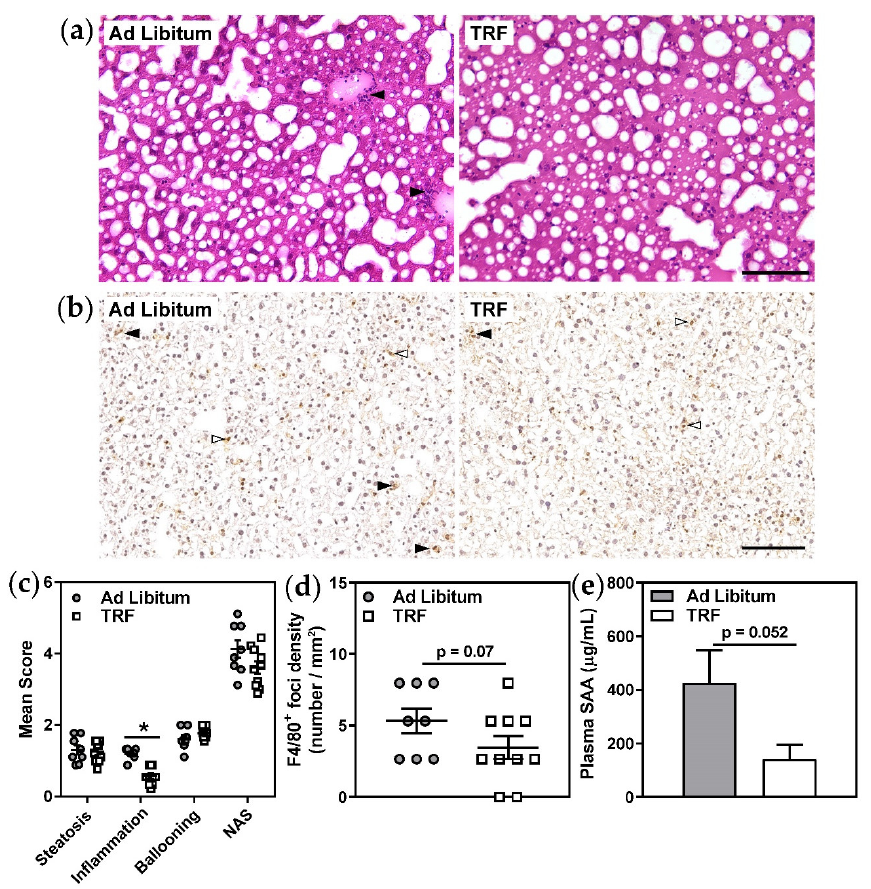
Figure 2. Two-week TRF appears to decrease liver inflammation in obese mice. ( a ) Liver tissue sections were stained with HE to visualize tissue morphology and inflammatory foci (black arrows). ( b ) Macrophages were visualized by immunohistochemistry for the pan-macrophage marker F4 / 80. Inflammatory foci, identified as clusters of F4 / 80-positive cells with small, rounded nuclei (black arrows), were counted. Kup ff er cells, identified as F4 / 80-positive cells with single large nuclei (white arrows), were excluded from counting. ( c ) Steatosis, lobular inflammation, ballooning, and NAFLD activity scores (NAS) were assessed in HE-stained serial sections. ( d ) F4 / 80-positive inflammatory foci densities were determined per section area. ( e ) Plasma serum amyloid A (SAA) was measured by ELISA. Scale bars represent 100 µ m. Data are means ± SEM, n = 8–10, * p <